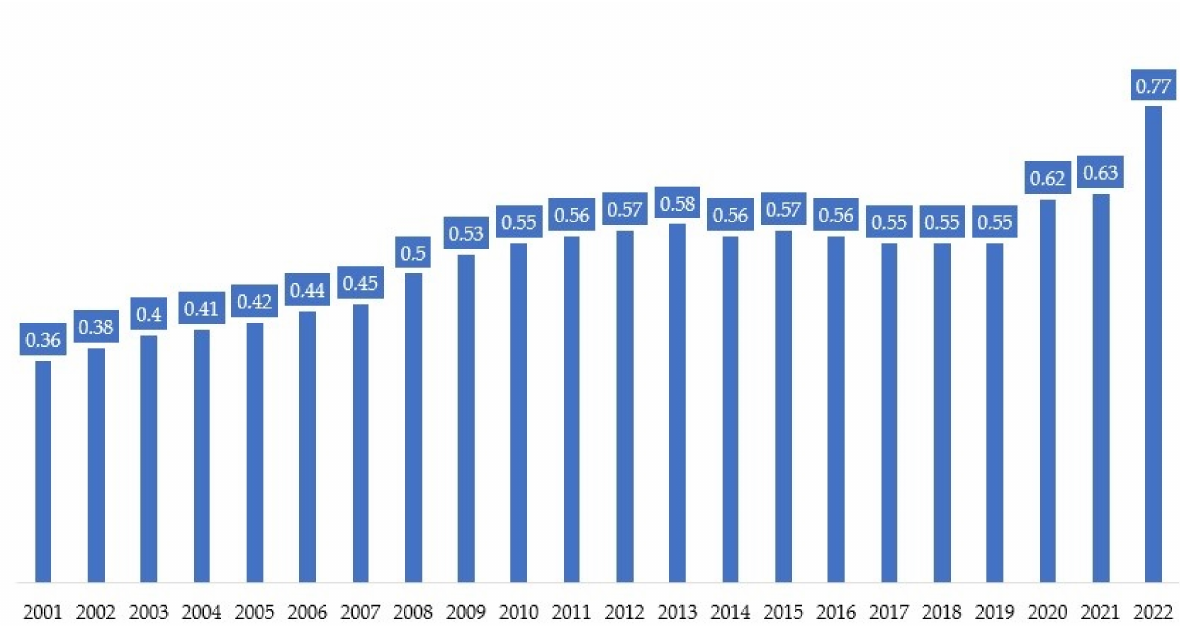
Figure 5. Average annual electricity prices in Poland from 2001 to 2022 [PLN/kWh]